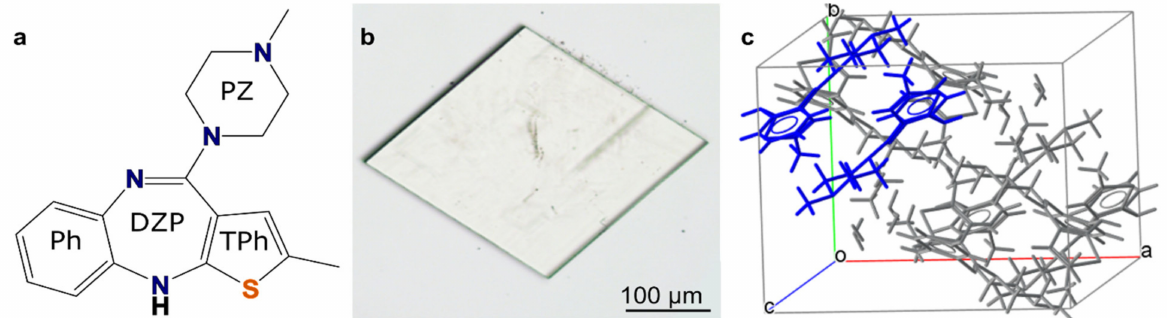
Figure 1. OZPN and its crystals. ( a ) The OZPN molecule: Ph, benzene ring; DZP, diazepine ring; TPh, thiophene ring; PZ, piperazine ring. ( b ) Optical micrograph of an OZPN crystal; the (002) face faces upwards. ( c ) The crystal structure of the dihydrate ethanoate mixed solvate 2OZPN · EtOH · 2H 2 O in space group P21/c (Cambridge Structural Database REFCODE WEXQEW [35]). One centrosymmetric OZPN SC 0 dimer is highlighted in